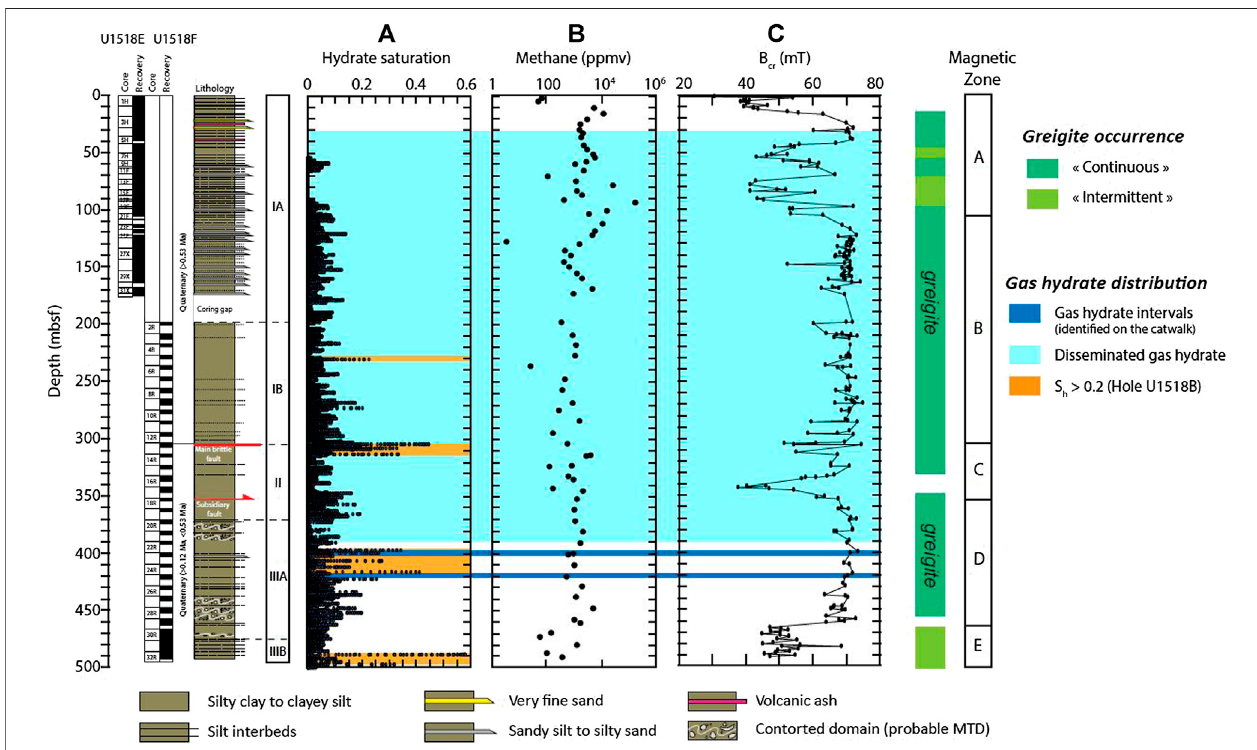
FIGURE5| Distribution ofgashydrateatSiteU1518basedonshipboardobservations (Wallaceetal.,2019) (A) HydratesaturationcalculatedfromLWDresistivity data (Cook et al., 2020). Here a value of n (cid:1) 2.5 for hydrate saturation calculation with Archie ’ s equation has been used (Cook and Waite, 2018) (B) Shipboard methane contents (C) RemanentcoercivityB cr .Occurrenceofgreigite(darkgreen:continuous,lightgreen:intermittent)fromrockmagneticmeasurementsisreportedontheright withthecoercivityzonesde fi nedinthisstudy.Thelightblueshadedzonecorrespondstodisseminatedgashydrateandthedarkblueshadedzonescorrespondto three gas hydrate-bearing sections identi fi ed aboard on the catwalk. The orange shaded zones correspond to intervals in Hole U1518B where hydrate saturation S h calculated from LWD resistivity data exceeds 0.2 (Cook et al., 2020). Core recovery, age and lithologic description are from Wallace et al. (2019).